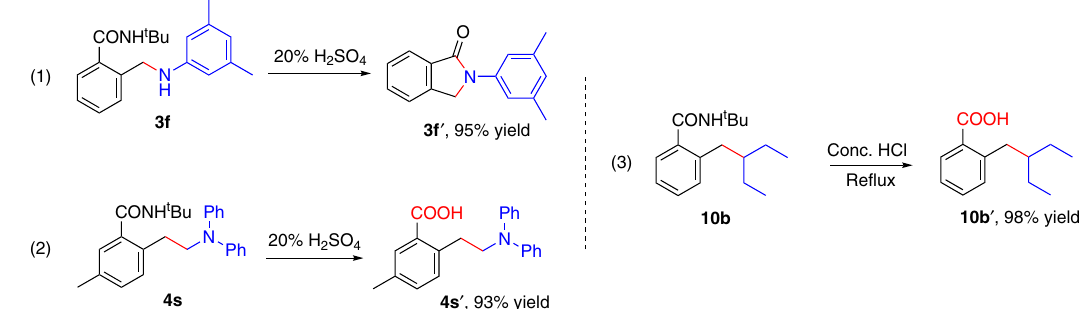
Fig. 7 Synthetic applications. (1) Synthesis of lactam 3f ’ . (2) and (3) Converted amides to acids.